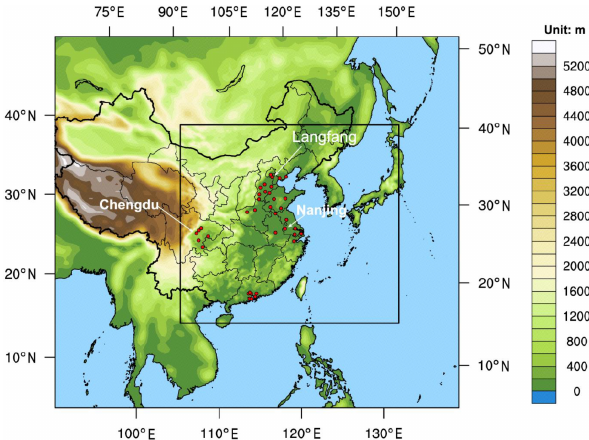
Figure 2. Model domains with the terrain distribution, and the lo- cations of cities where the surface observations of air pollutants are used for model evaluation. Langfang, Nanjing, and Chengdu marked in this figure indicate where the SIA observations are col- lected for evaluation of SIA